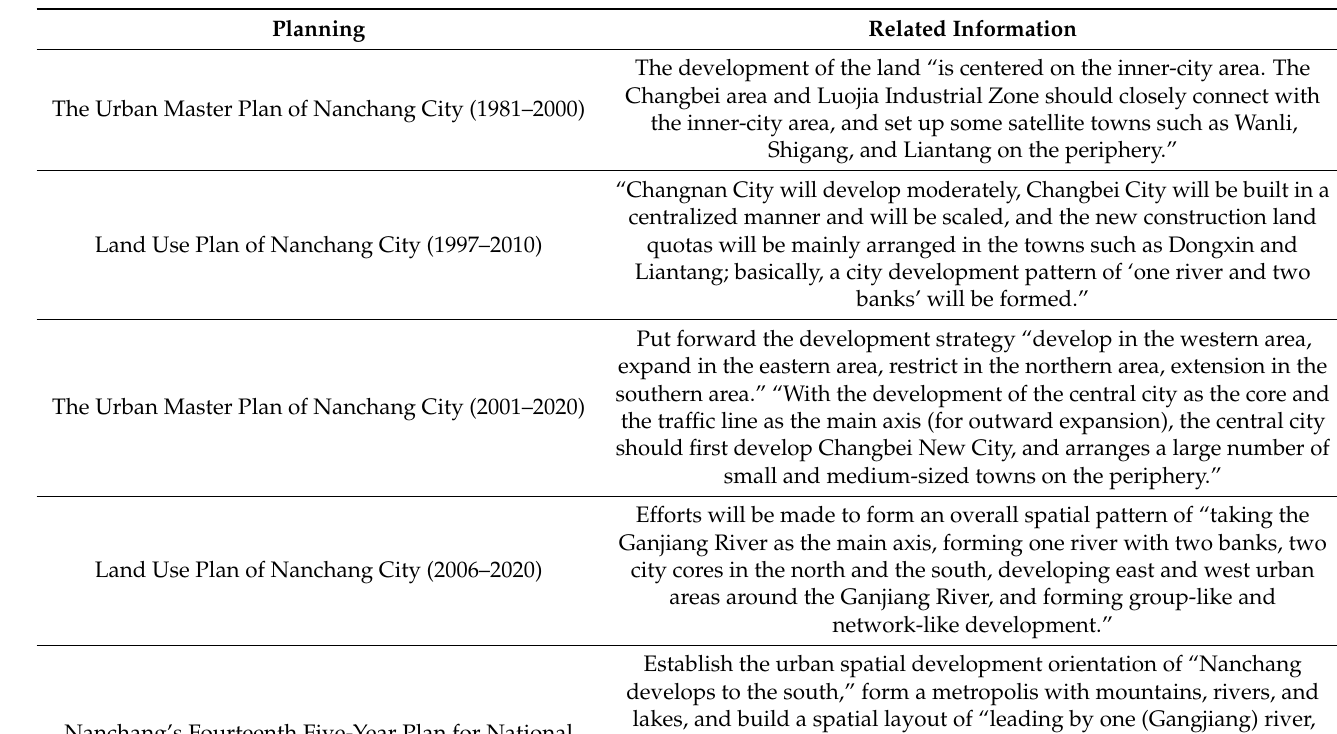
Table A2. Nanchang’s urban planning policies.